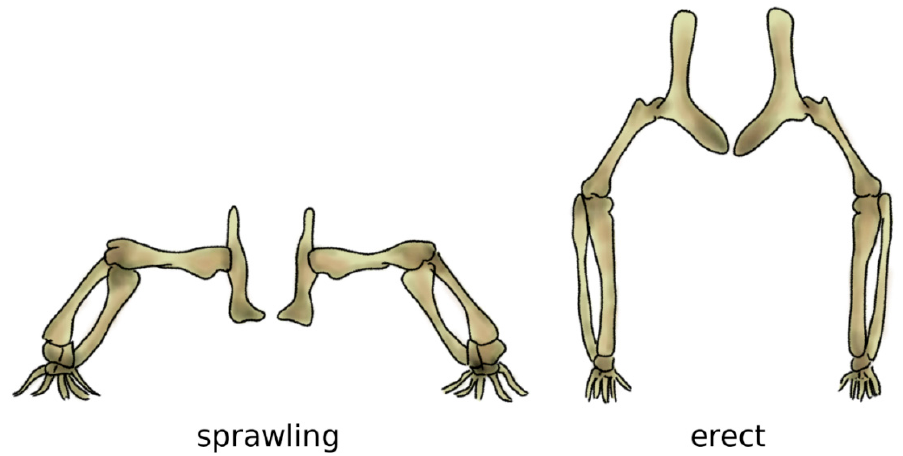
Figure 6. The sprawling (left) and erect (right) postures. In the sprawling posture, the long bones of the limbs are mostly loaded in bending, whereas the load becomes mostly compressive when standing erect. Adapted from Reference [76].